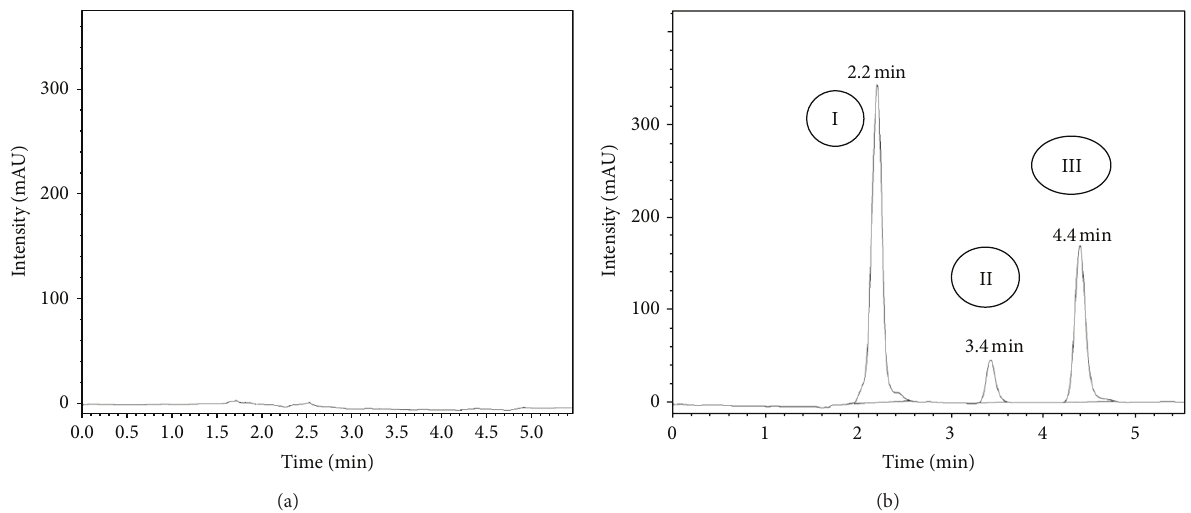
Figure 2: Representative HPLC chromatogram for the analysis of PTZ and ETD in rat plasma: (a) blank rat plasma, (b) rat plasma spiked with ETD (RT = 2.2 min) (I), IS (RT = 3.4 min) (II), and PTZ (RT = 4.4 min) (III), respectively.